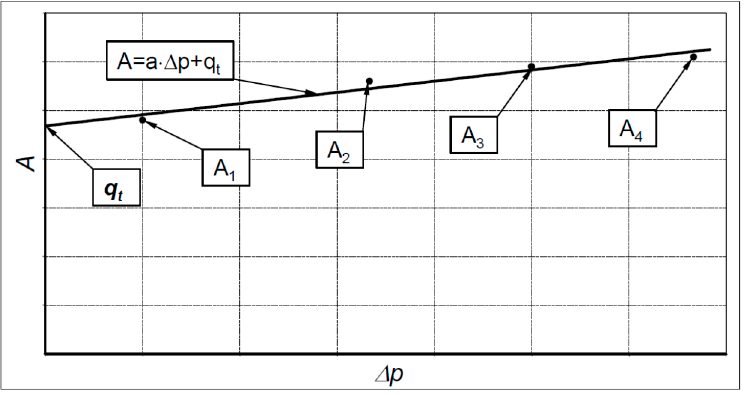
1 and shaft speed n [6]. Energies 2020 , 13 , x FOR PEER REVIEW